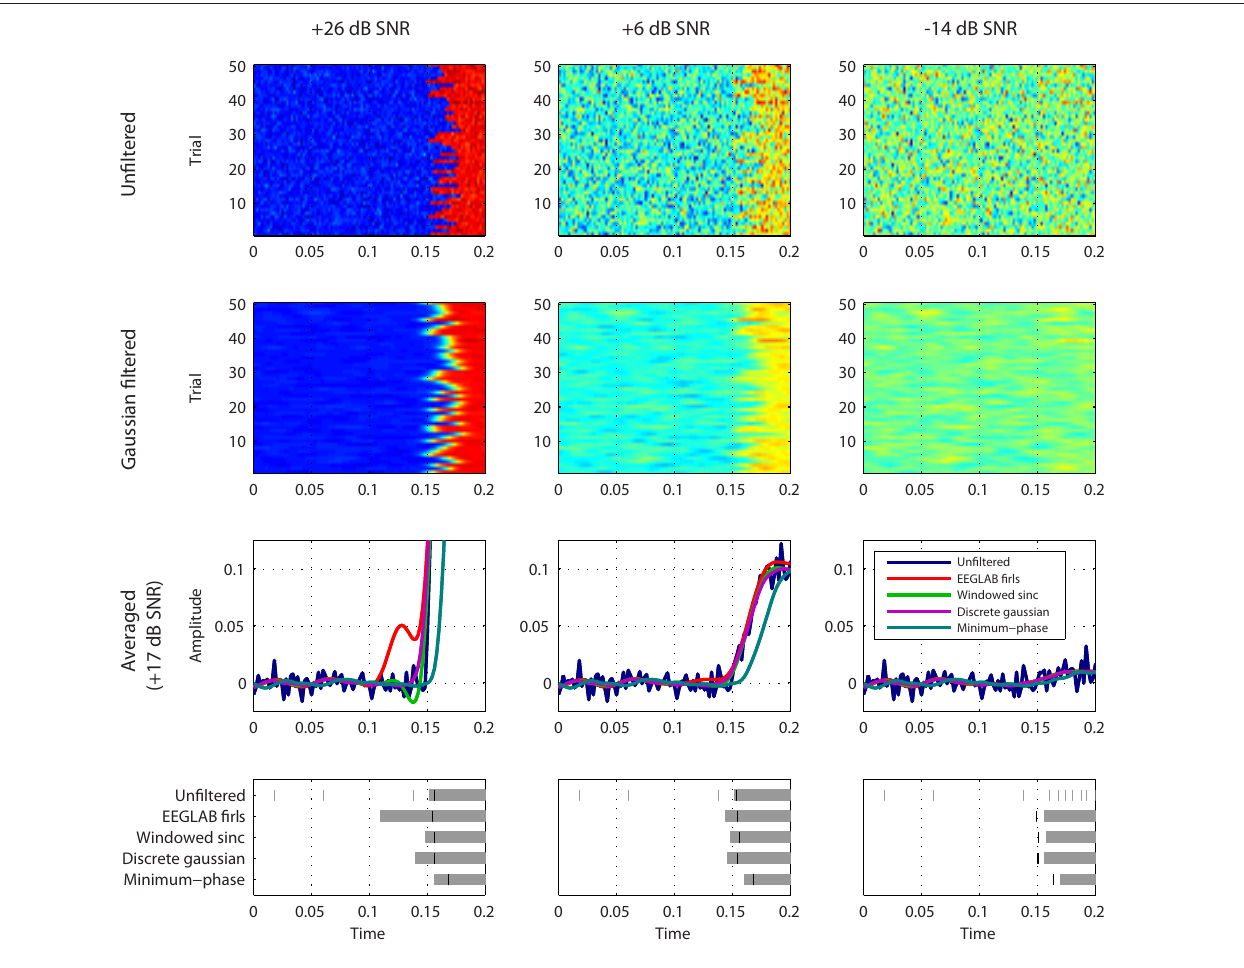
Figure 1 | impact of filter type and signal-to-noise ratio (SNr) on the time course of the averaged signal and the detected signal onset latency in the simulated dataset (sampling frequency 500 Hz; step signal; signal onset 150–180 ms) as defined by Vanrullen (2011). The simulated dataset was filtered with the EEGLAB firls based filter, a windowed sinc FIR filter (Widmann, 2006), a discrete Gaussian kernel filter (Lindeberg, 1990), and a minimum-phase converted version of the Gaussian